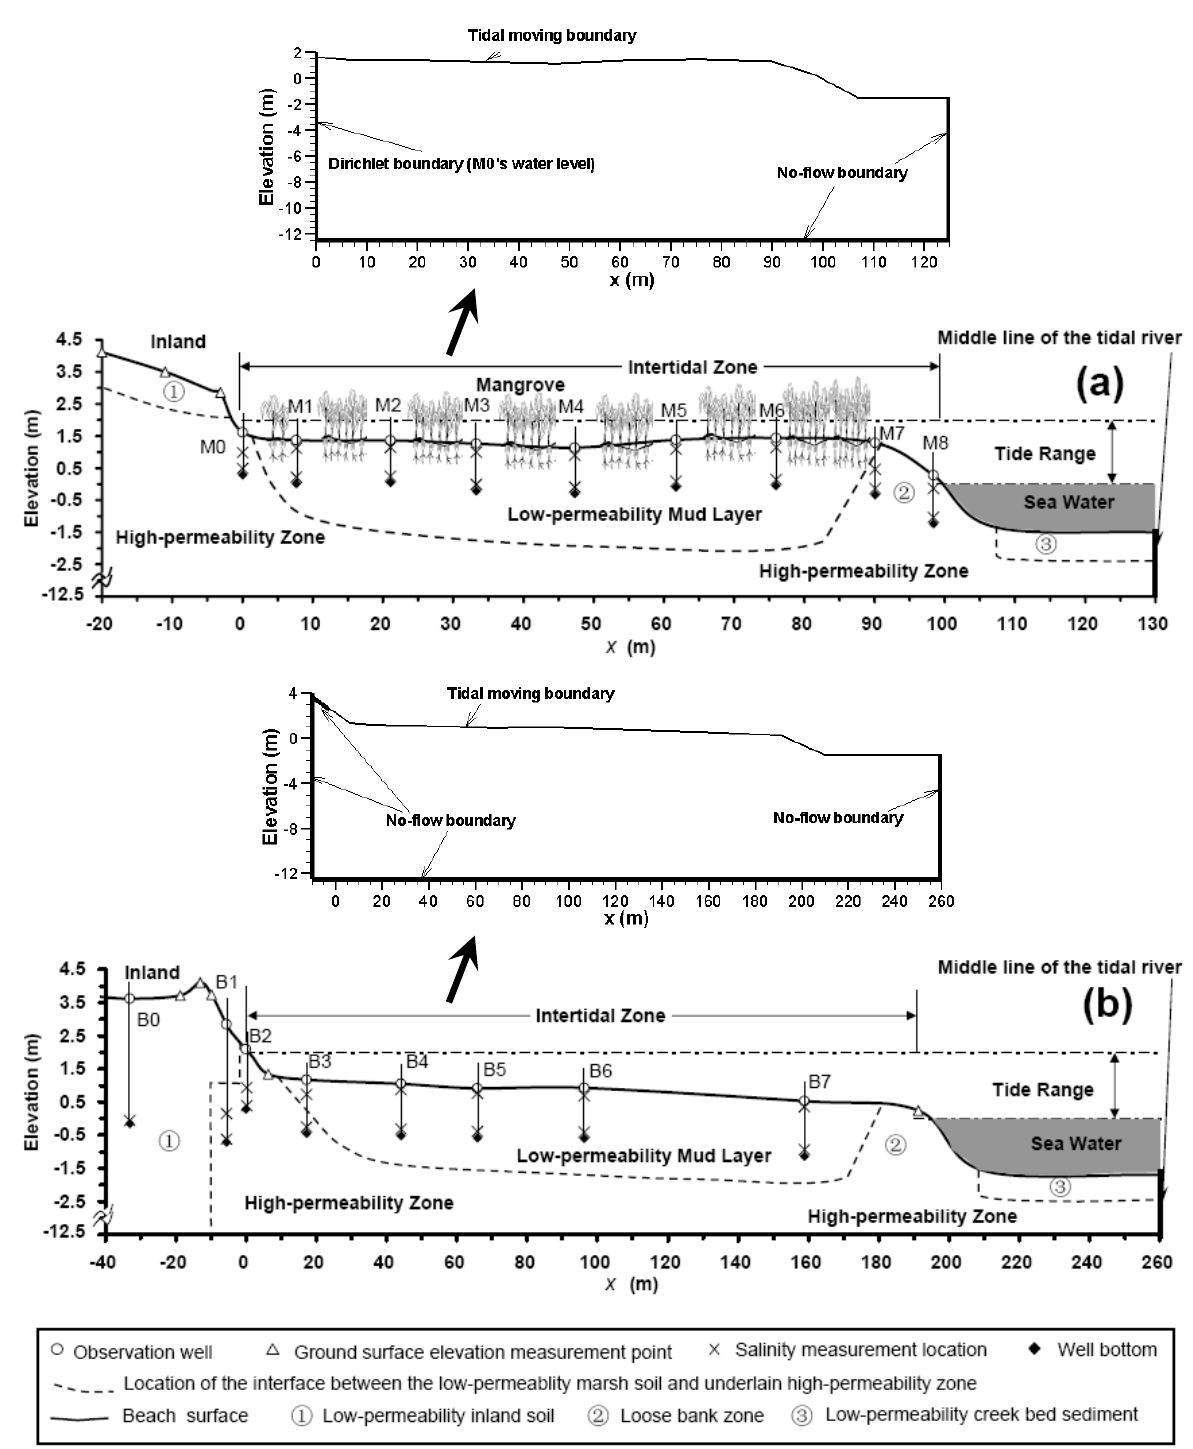
Fig. 2. The cross-section of (a) the mangrove transect M-M 0 and (b) the bald beach transect B-B 0 . The intertidal zone is located within 0m ≤ x ≤ 100m for the mangrove transect and 0m ≤ x ≤ 190m for the bald beach transect, where x is the seaward distance from the high tide mark. The detailed information about monitoring wells is presented in Fig. 3 and Tables 1 and 2. The conceptual hydrological models of both transects are also shown in this